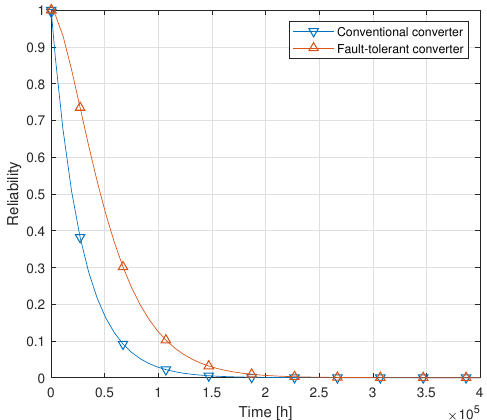
Figure 6. Reliability functions of the proposed fault-tolerant converter and the conventional non-fault-tolerant converter.